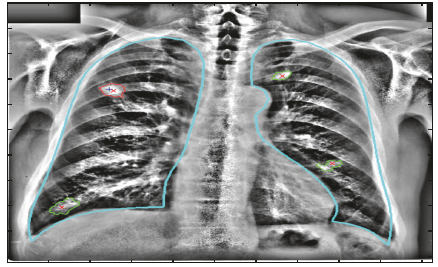
Figure 5: Potential nodule